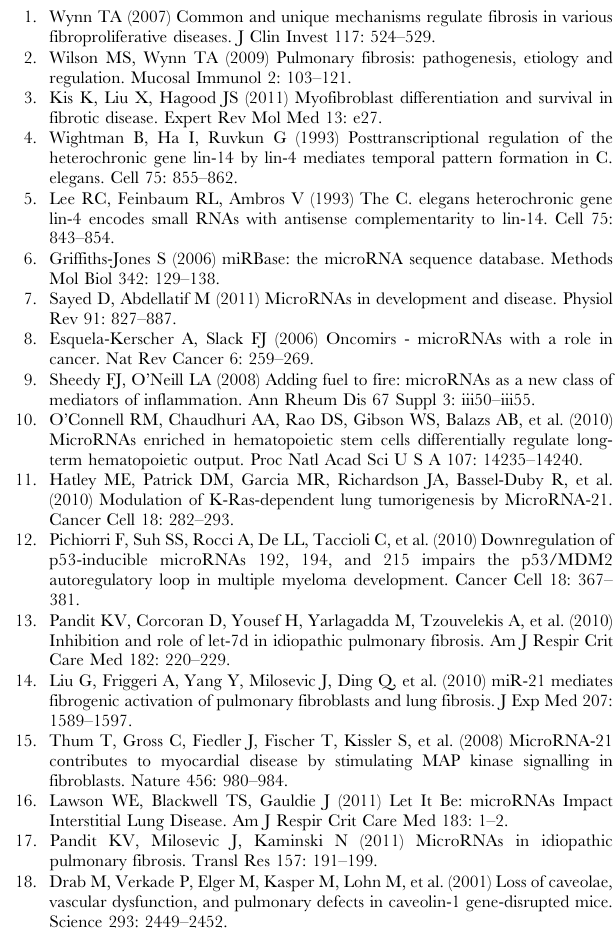
Table S3 Pulmonary expression of miR-199a-5p in 10 IPF and 10 controls (dataset GEO accession number GSE13316). Table S4 List of the 133 genes modulated by miR-199a-5p in lung fibroblasts that are also dysregulated in lungs from C57BL/6 mice 14 days after bleomycin